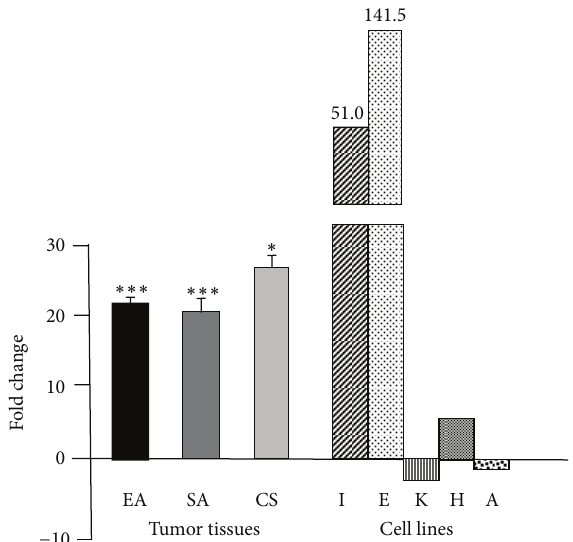
Figure 4: Relative expression of P1 transcripts and P2 transcripts in both endometrial tumors and cultured cell lines. Fold change of P1 transcript versus P2 transcript in each tumor type, assessed by ΔΔ Ct, was calculated for each individual sample and then averaged. Statistical significance is assessed by a two-tailed 𝑡 -test with unequal variances using normalized expression values ( Δ Ct). EA is endometrioid adenocarcinoma, SA is serous adenocarcinoma, and CS is carcinosarcoma. Cell lines are Ishikawa H (I), ECC-1 (E), KLE (K), Hec50co (H), and AN3CA (A). ∗ 𝑃 < 0.05 , ∗∗∗ 𝑃 < 0.001